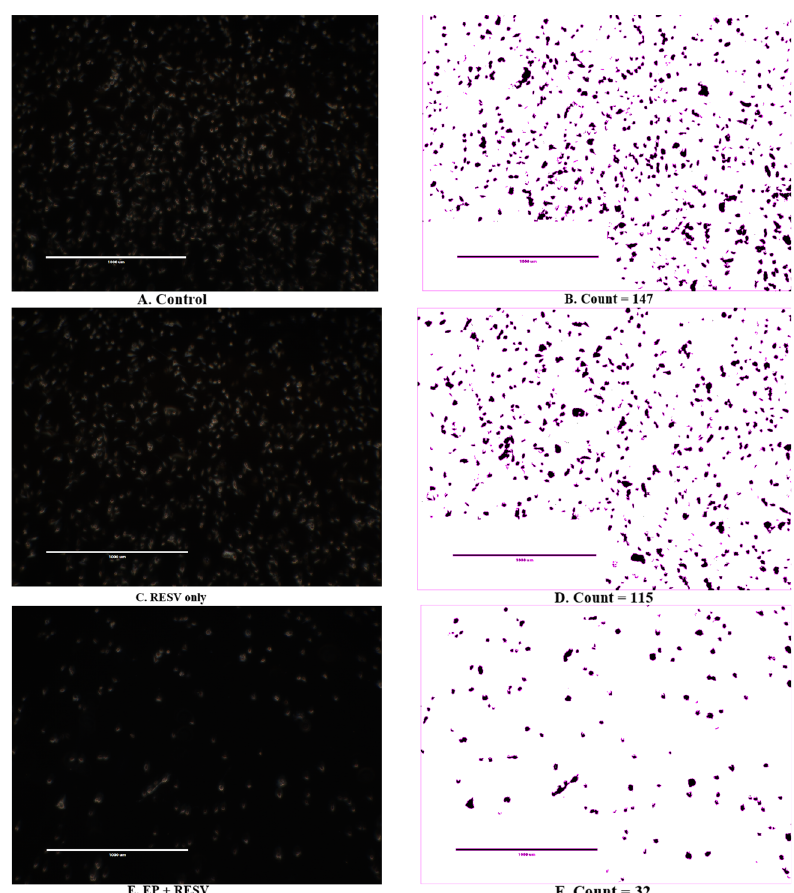
Figure 5. MDA-MB-231 live cell imaging and image segmentation count at 24 h after treatments